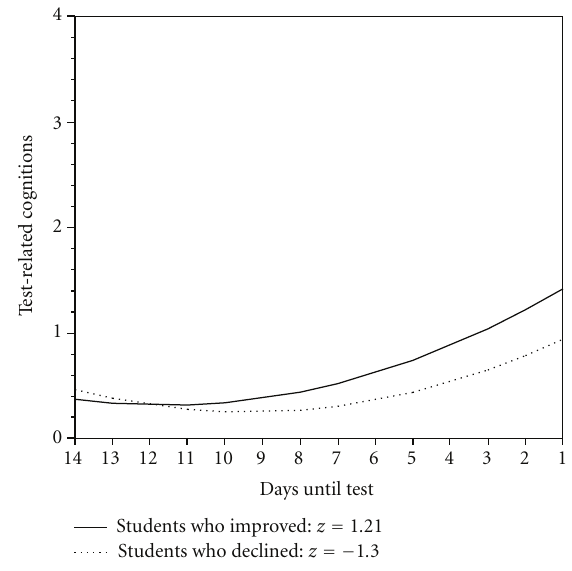
Figure 3: Average intensity of test-related cognitions by improve- ment classification. Note: The two lines reflect the growth curves of the parameters for averaged lower and upper quartiles considering the relative improvement between the two